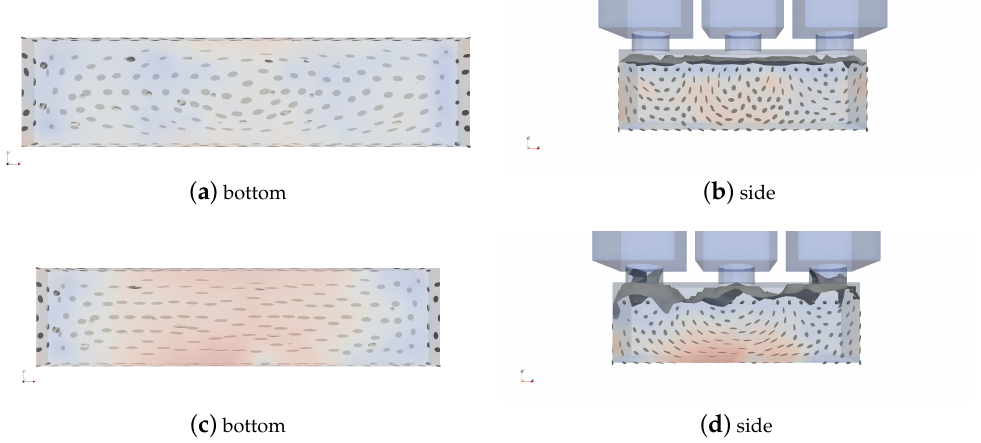
Figure 6. Side-by-side comparison of the fiber orientations in the bottom layer and in the side layer. One can see the differences in the bottom-layer orientation distributions differ from the side distributions. Since, in a bending test, the part that is on the under or top side take the largest stress, turning a sample side-ways changes the tested